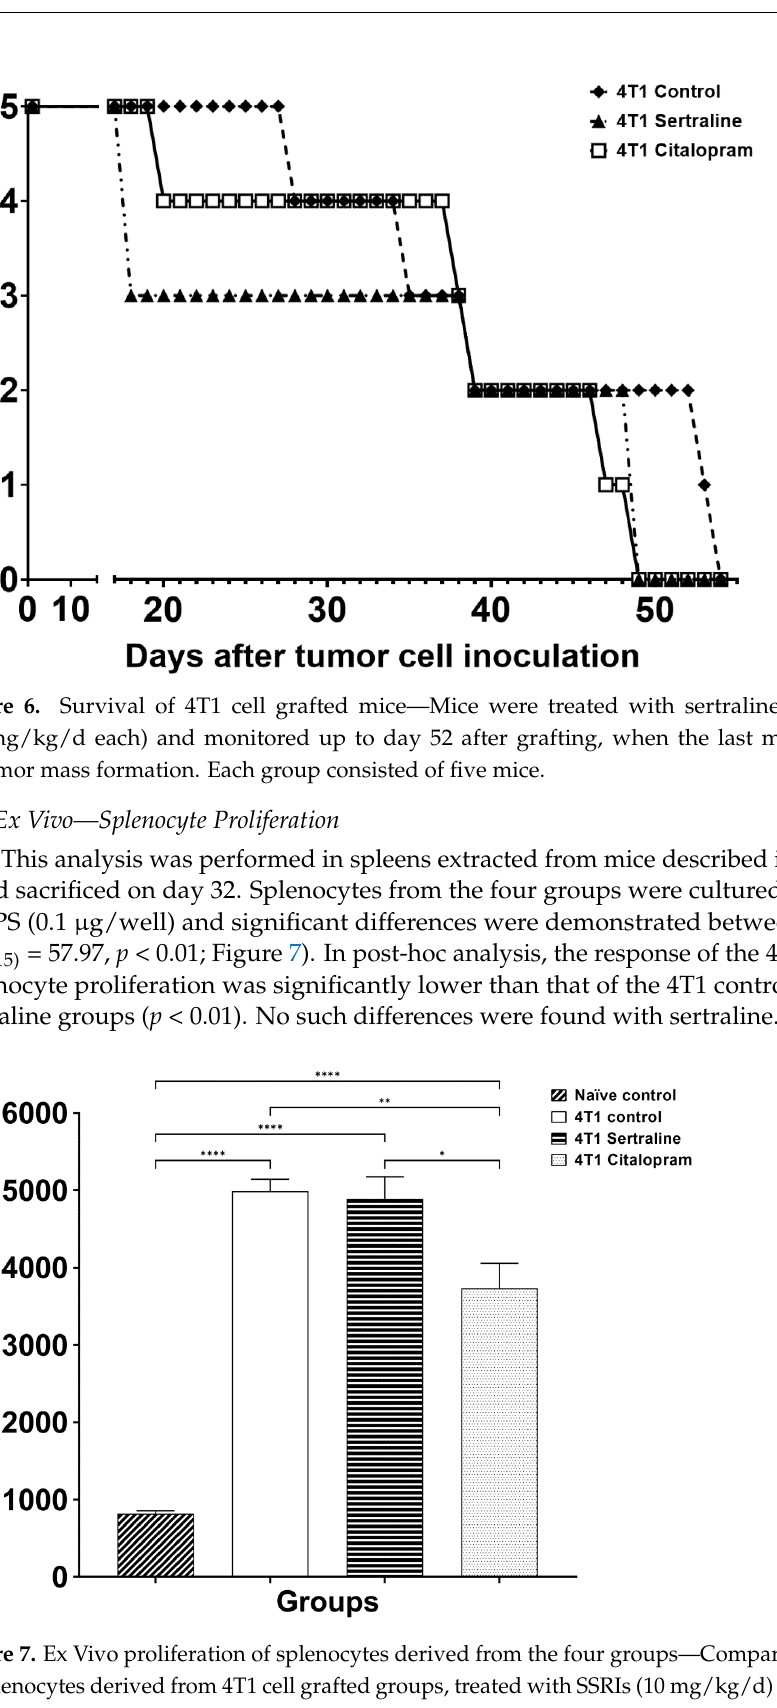
Figure 5. Effect of sertraline or citalopram (10 mg/kg/d) on tumor volume of 4T1 cell inoculated mice — Tumor volume in mice treated with SSRIs (10 mg/kg/d) 20 days after 4T1 cell inoculation are expressed as mean± SE ( n = 5 in each group). * p < 0.05.